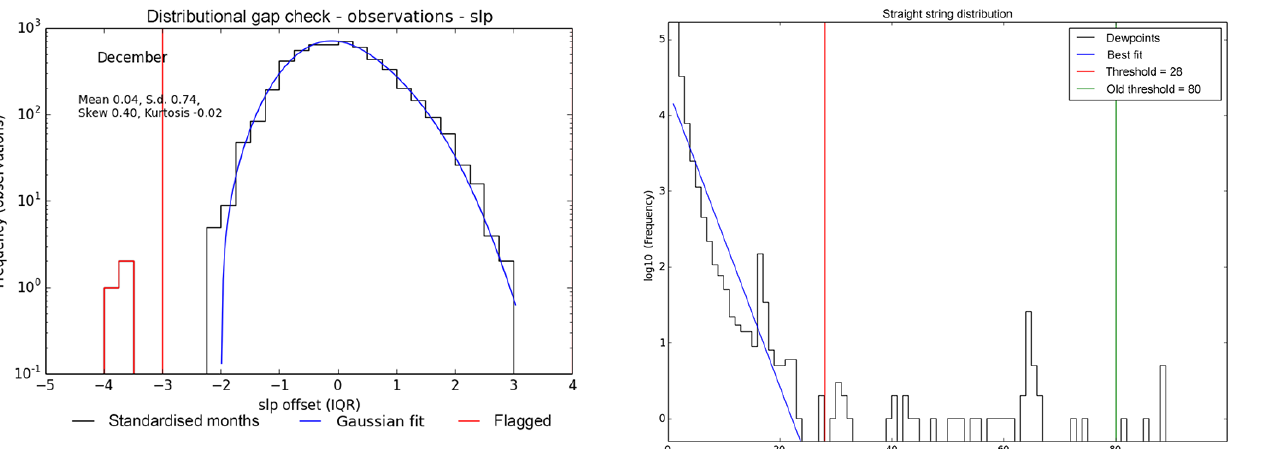
Figure 4. The improved distributional gap check working on SLP data from 764230–99999 Durango (24.06 ◦ N, 104.60 ◦ W, 1872m). Using a Gaussian distribution without skew and kurtosis may have included cluster of observations at around − 4 IQR which, being beyond the threshold indicated by the vertical red line, are removed in this upgraded test.